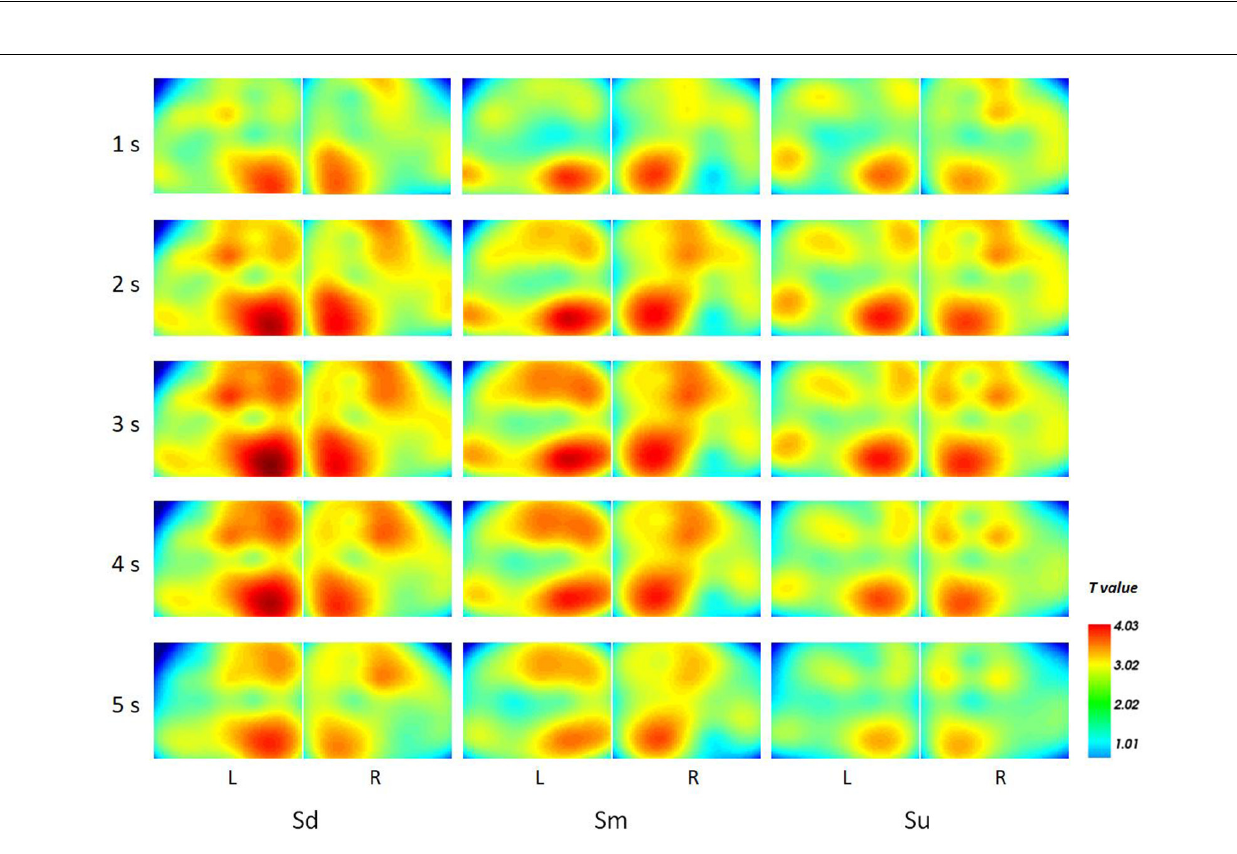
FIGURE 8 | The topographical maps of t -test results of the HbO signal between the observation and baseline block of each channel from 1 to 5